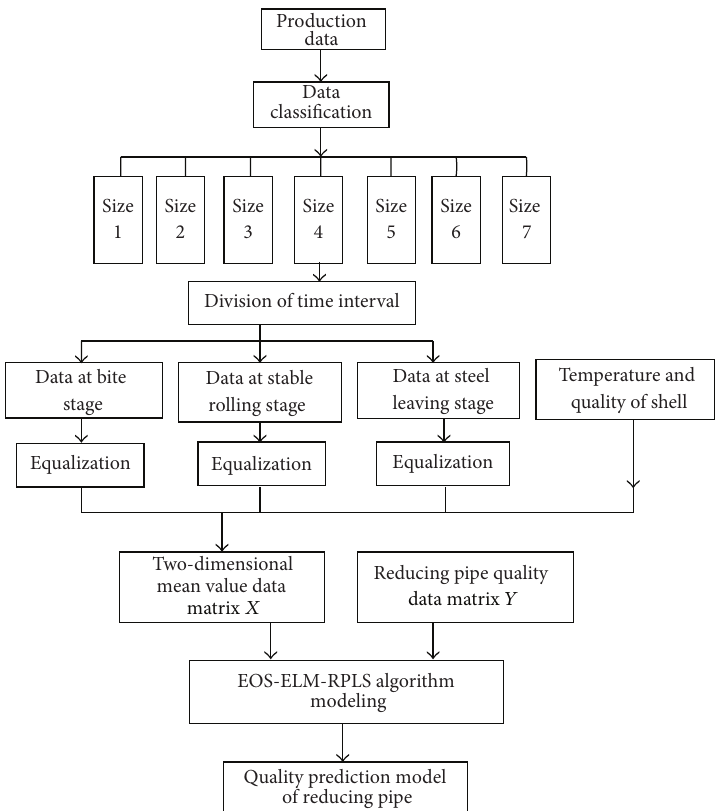
Figure 3: Frame chart of reducing tube quality prediction model.